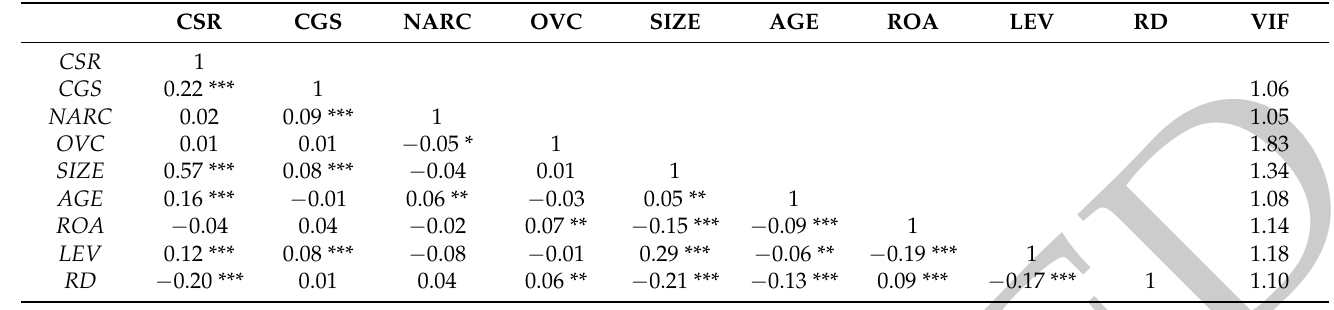
Table 5. Pearson matrix.